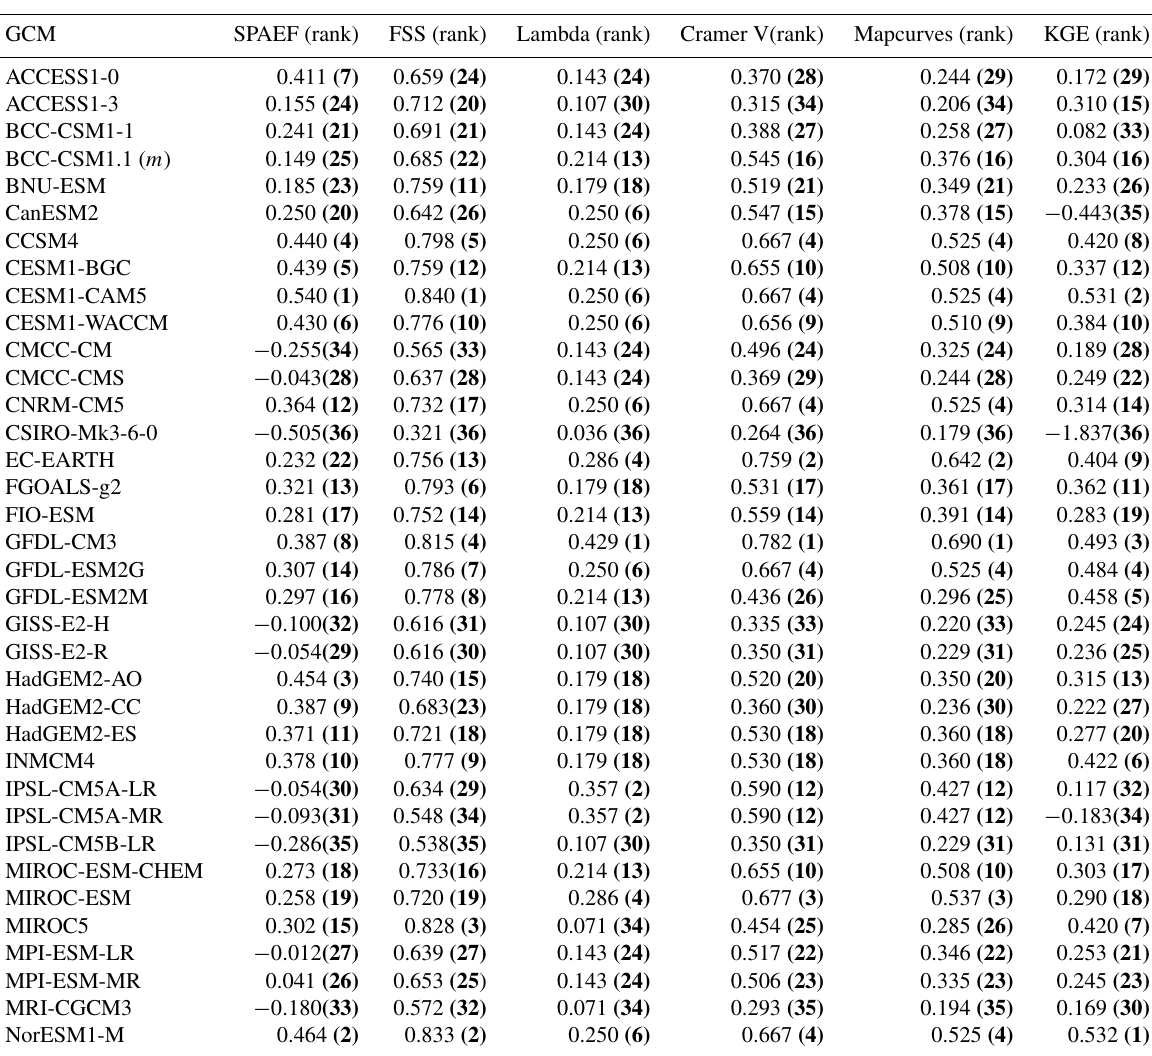
Table 3. GOF values and ranks of GCMs obtained using different spatial metrics for mean annual precipitation. Bold numbers within brackets represent the rank of